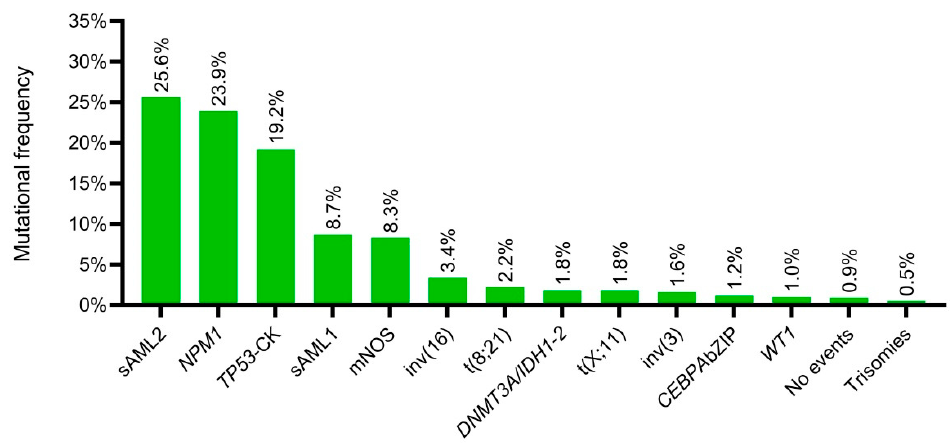
Figure 6. Molecular classes’ distribution according to the Tazi et al., 2022 genomic classification. CK: Complex karytotype. mNOS: Not class defining mutations.